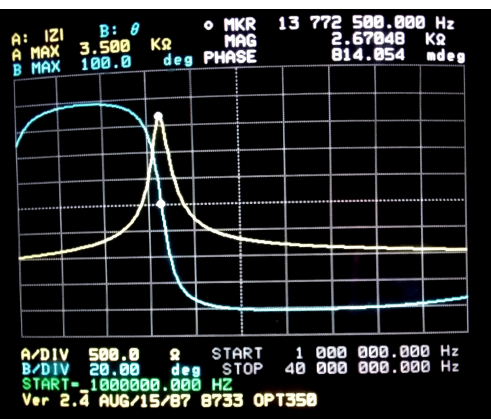
Figure A2. Photograph of impedance analyzer screen during